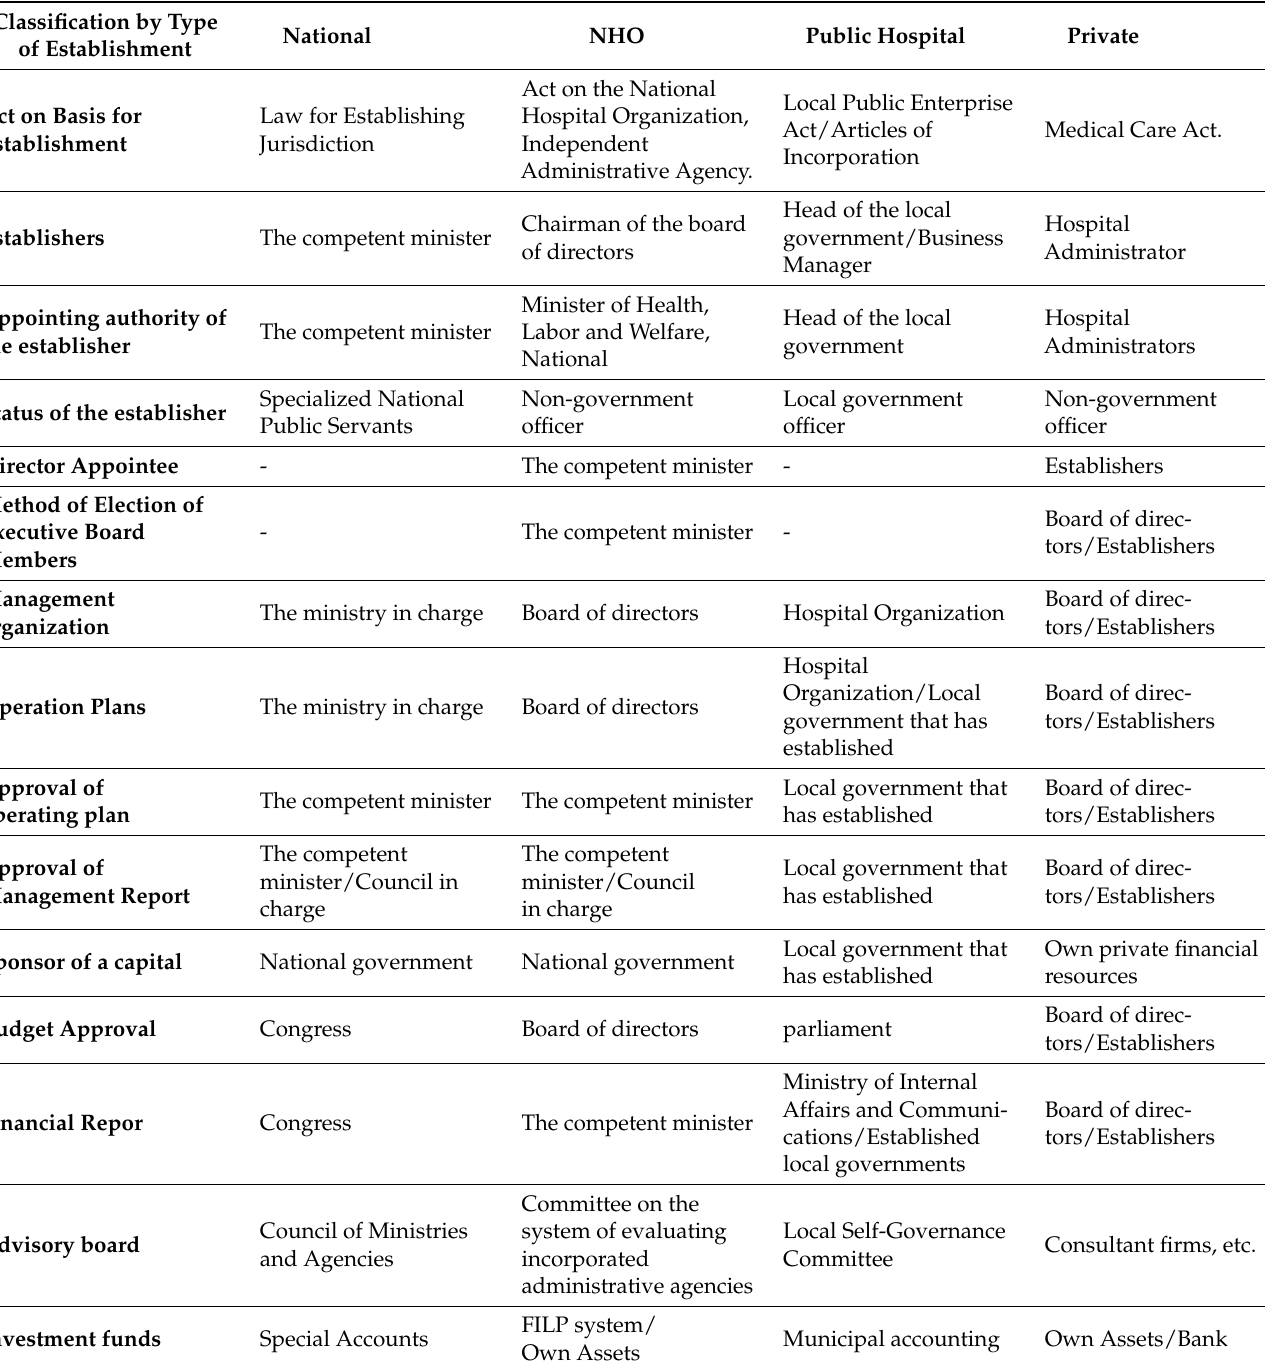
Table 1. Governance structures of health organizations; for more detailed information see Supplementary Material Table